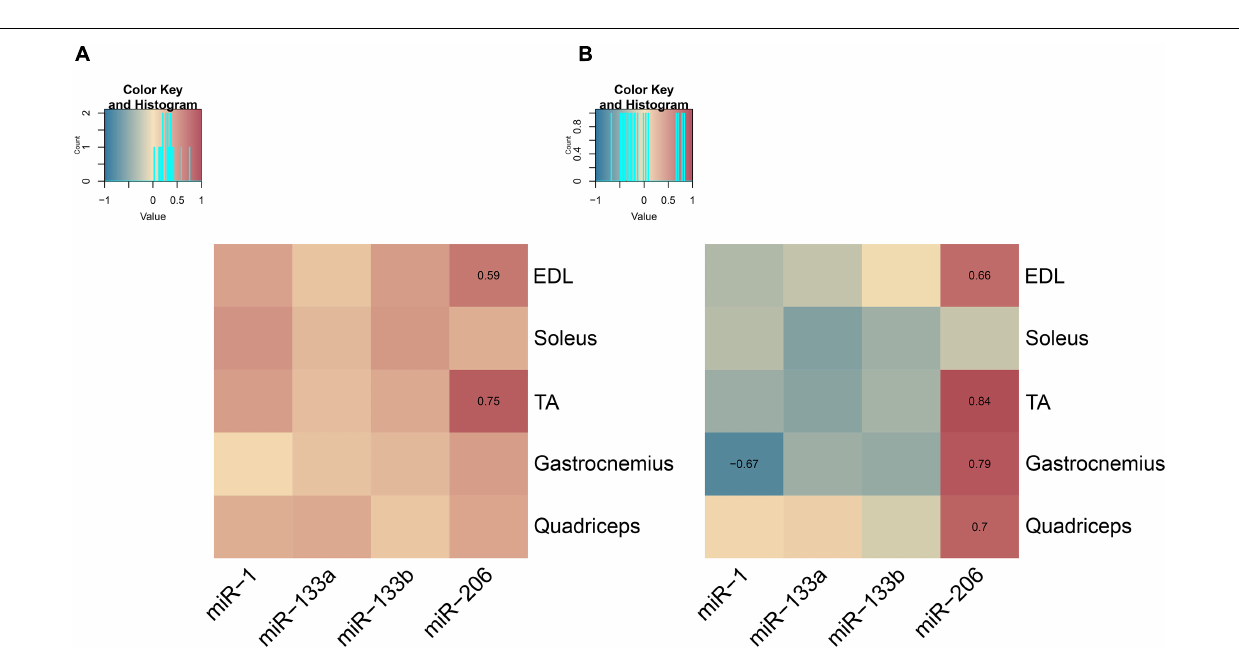
FIGURE 9 | Exosomal myomiR levels normalized to the weight of the skeletal muscles follow similar profile patterns. Muscle-derived exosomal myomiR levels presented a similar correlation to the growth of muscle with age. (A–E) Exosomal myomiR abundances per muscle weight derived from all the muscle tissues were lower in the first 4 weeks of life compared to the older ages. During early adolescence, the exosomal myomiR levels reached a peak followed by similar trendlines for the majority of the skeletal muscles. Normalized miR-206 levels encapsulated within exosomes derived from all the skeletal muscle tissues were very low throughout the first-year lifespan (A,C–E) , with the exception of soleus-derived exosomes in which the levels of miR-206 were higher (B) . Data on illustrations represent the mean values ± SEM. (F–J) Correlation analysis with the Spearman method revealed a significant positive correlation between the secreted miR-1, miR-133a, and miR-133b exosomal levels normalized to muscle weights for all the skeletal muscles. (G) A significant positive correlation was demonstrated between miR-206 and the other three myomiRs in soleus-derived exosomal levels normalized to the soleus weight. Correlation (rho) values are shown within the squares and those close to